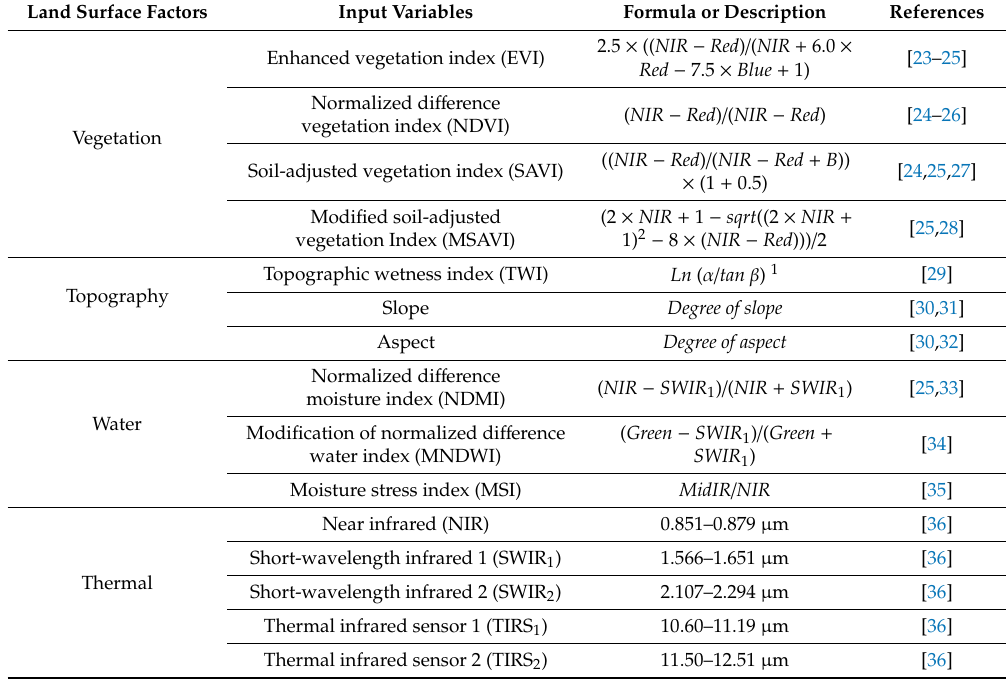
Table 1. Variables of the SDAP model for prediction severe drought